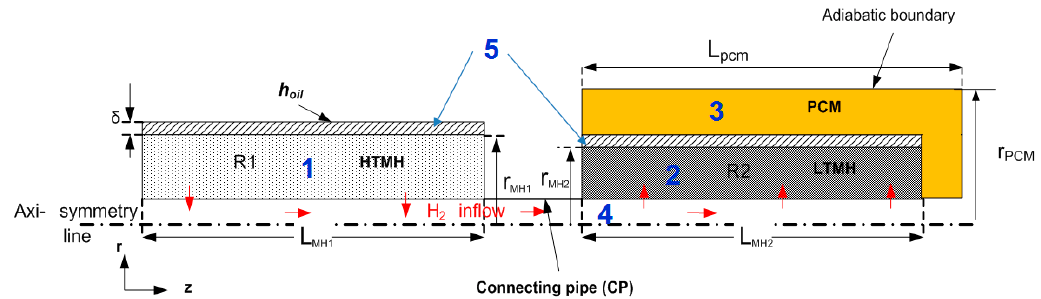
Figure 4. Axis-symmetric (2-D) computational volume.